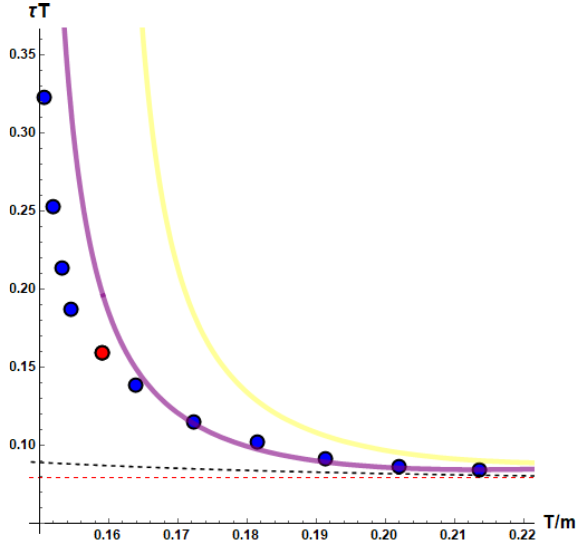
Figure 17 . A comparison between the relaxation time (cid:28) numerically computed from the QNMs ((cid:12)lled bullets) and several hydrodynamic quantities. (I) the di(cid:11)usion constant D (yellow), (II) the formula for the generalized liquid relaxation time (cid:28) (4.33) (purple) (III) the approximated formula for the di(cid:11)usion constant (4.17) (dashed). Notice that for (cid:0) (cid:28) (cid:28) 1 the corrections from (cid:28) rel are small and (cid:28) (cid:25) D=c 2 . In general we found a good agreement between the data and the theory. The red bullet indicates the self-dual